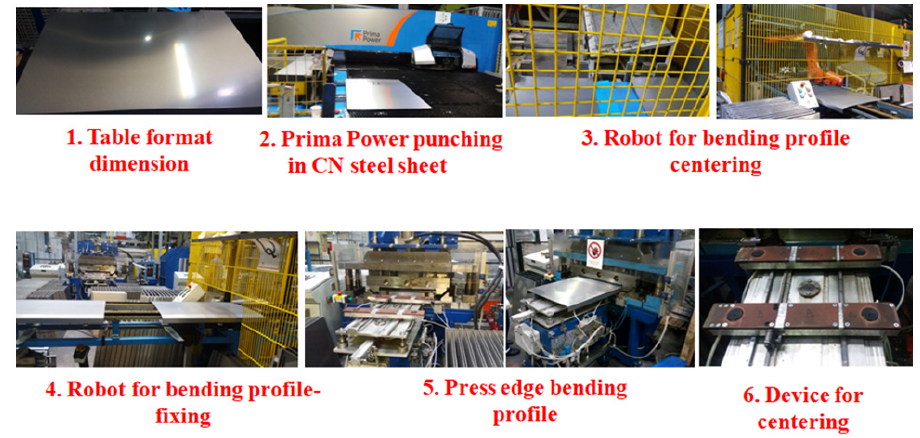
Figure 14. Details of the process.